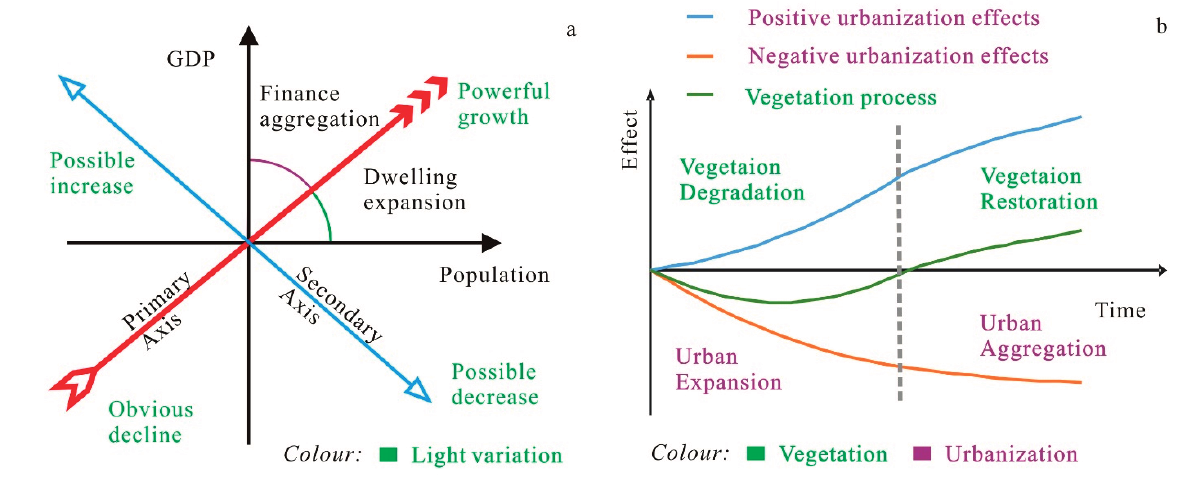
Figure 11. Urbanization stage and the effect on night light and vegetation: ( a ) relation between urbanization stage and light [46], and ( b ) relation between urbanization stage and vegetation